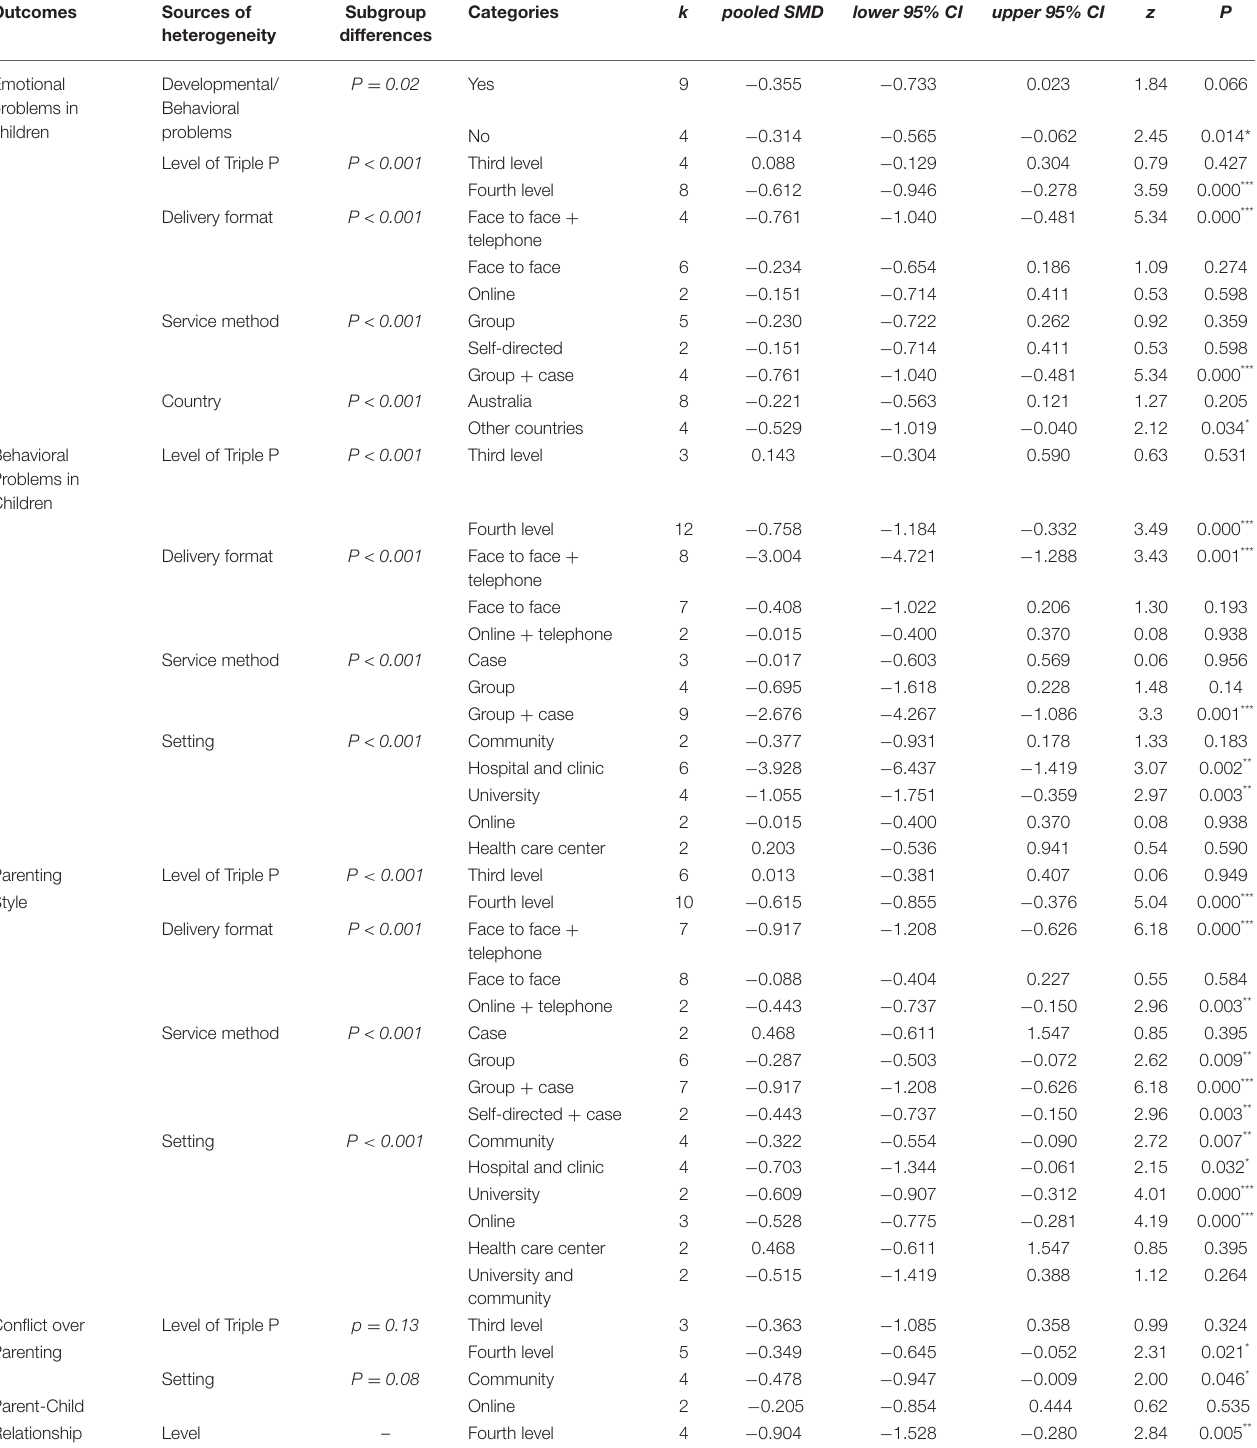
TABLE 3 | The results of the subgroup